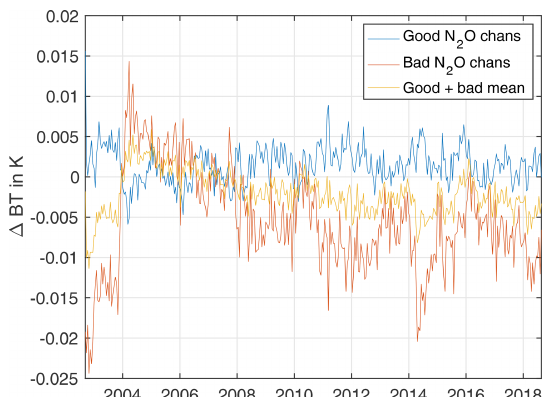
Figure 21. Slope of the AIRS anomaly residuals separated by A+B (fit channels), A-only, and B-only. This illustrates trends in the A- only and B-only channels relative to A+B channels in some mod- ules. The A-only and B-only channels were not used in the fitting, so they are not strictly residuals but observed – computed differences.